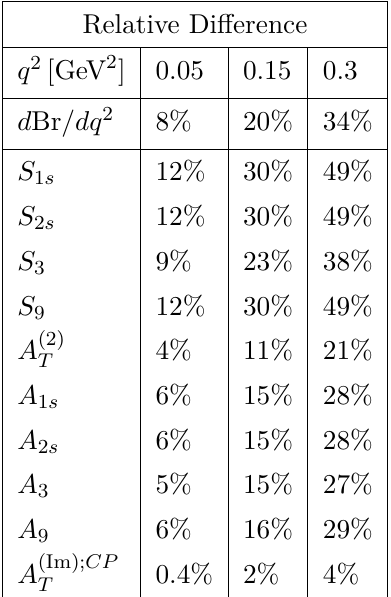
Table 4 . Relative difference between the complete expression for the observables and the photon- pole approximation for three different values of q 2 ∈ [4 m 2 we consider δ C S 9 and A (2) T